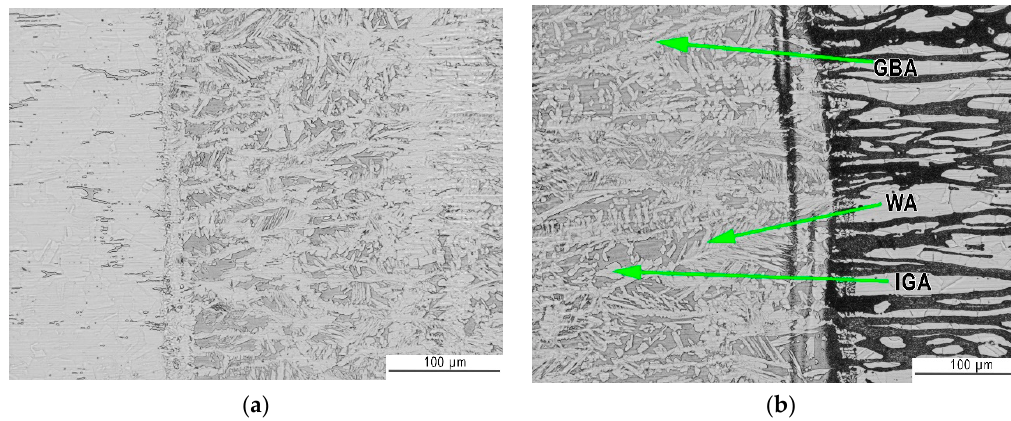
Figure 7. Metallographic structure (LM) of: ( a ) 316L austenitic stainless steel → HAZ → WM and ( b ) WM → HAZ → 2304 duplex stainless